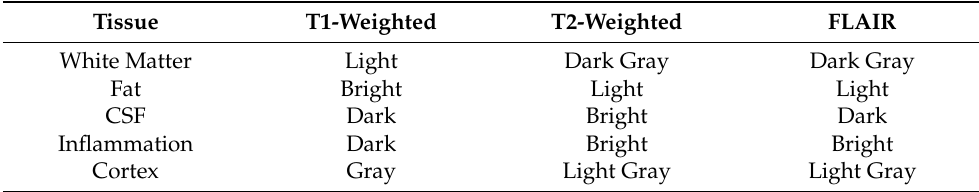
Table 1. Analysis of basic MRI sequences in the context of brain tumors.